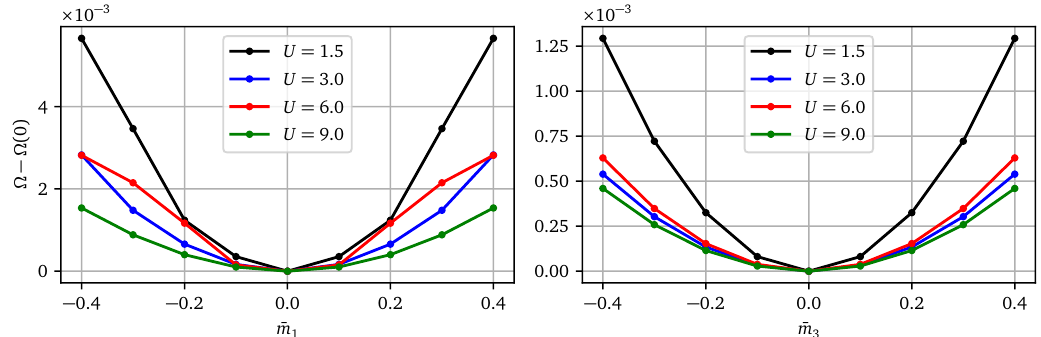
Figure 4: Left panel : The Potthoff functional Ω as a function of the charge-density- wave Weiss field ¯ m at quarter-filling. Right panel: the same, for the charge-density- 1 wave Weiss field ¯ m . See Table 2 for an illustration of the density-waves m 3 The symmetric state (no charge density wave) ¯ m Ω , Weiss fields) are in